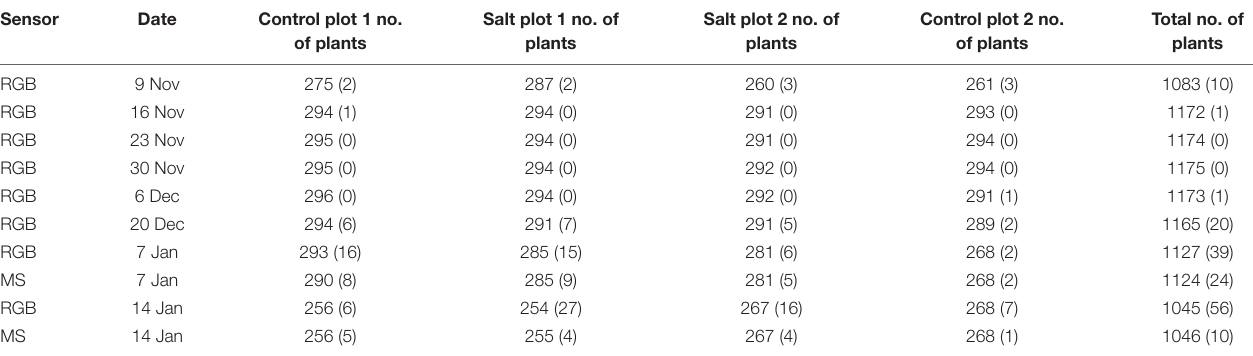
TABLE 2 | Number of plants delineated per plot for the RGB and multi-spectral (MS) imagery for each of the eight campaigns and in brackets, number of plants omitted by the automatic delineation process validated against visual assessment of the RGB and multi-spectral imagery. Sensor Control plot 1 no. Salt plot 1 no. of Salt plot 2 no. of Control plot 2 no. Total no. of of plants plants plants of plants